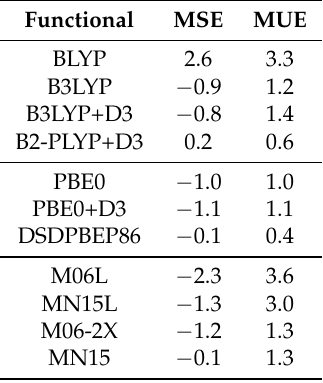
Table 3. Statistical evaluation of density functional theory methods for determination of relative energies of the 10 lowest-lying isomers of C 2 Si 2 H 4 .